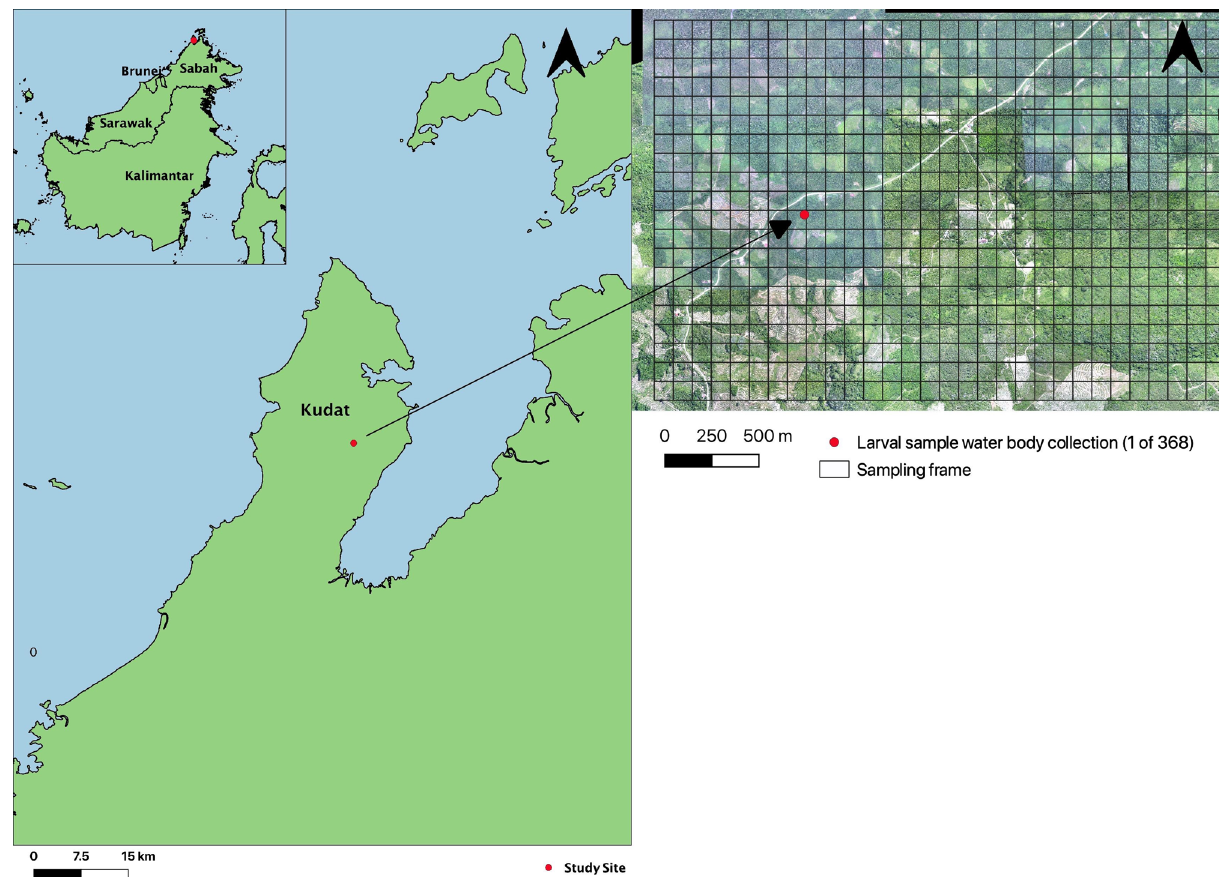
Figure 4. Map of Sabah, Malaysian Borneo, including drone image of sampling site in